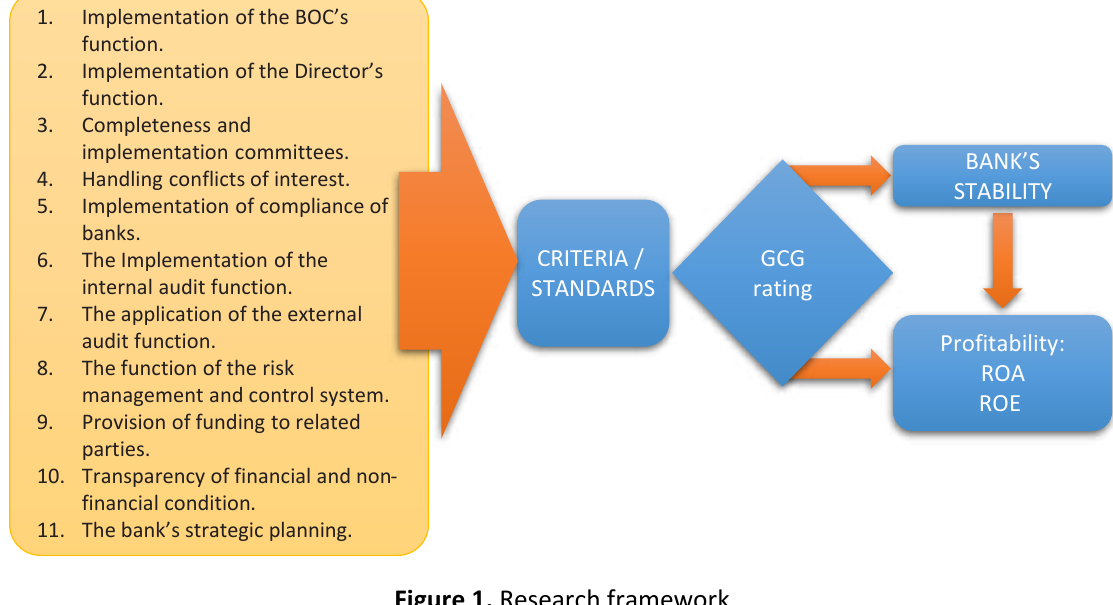
Figure 1. Research